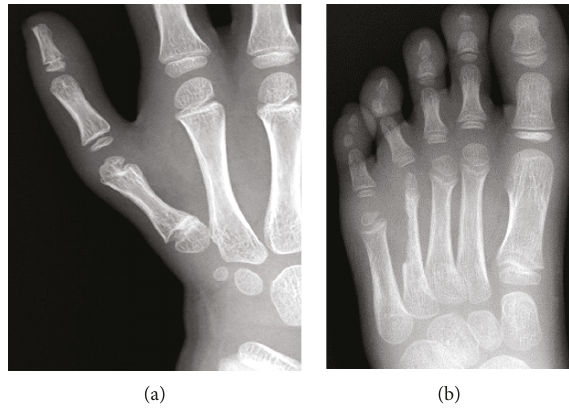
Figure 5: Radiographs of 2 years of follow-up: (a) hand and (b) foot.